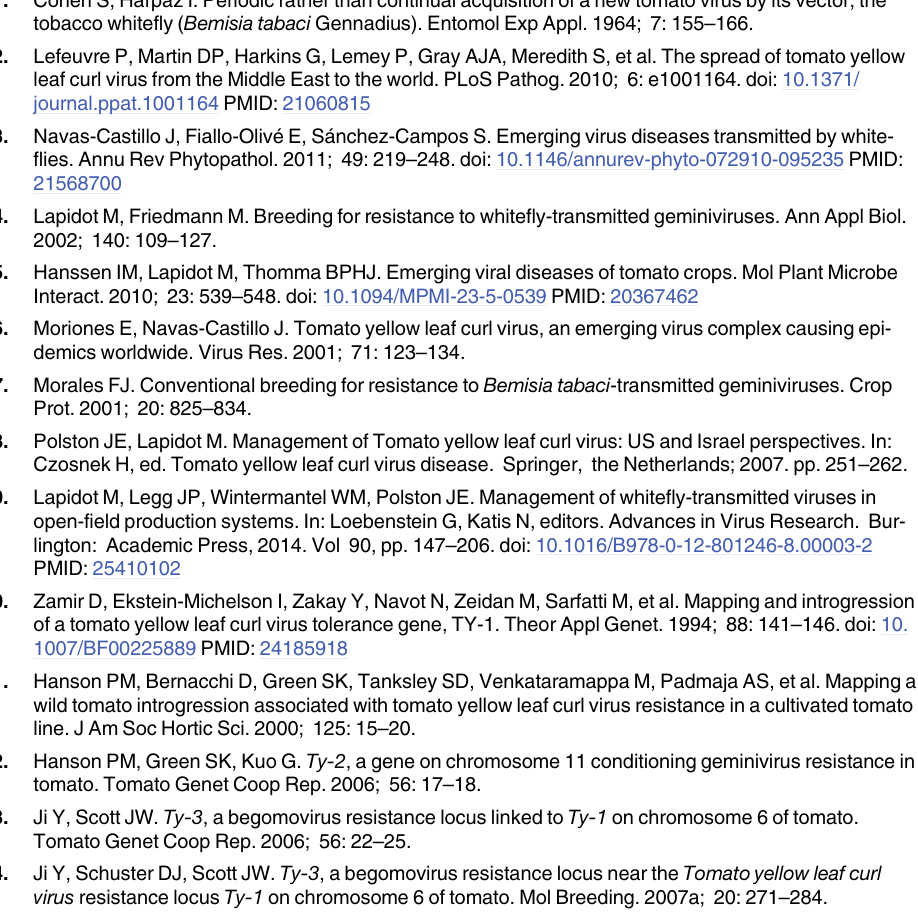
S1 Table. DNA markers displaying polymorphisms between the resistant line TY172 and the susceptible counterpart M-82, on tomato chromosome 4. Markers are displayed accord- ing to their approximate distance in Kb from Nac1